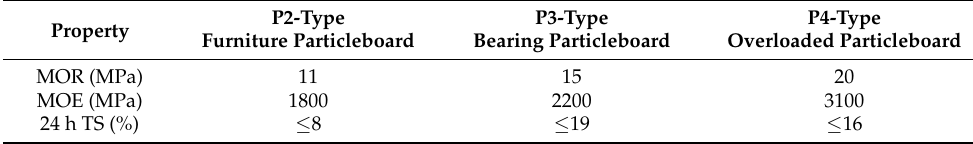
Table 5. Requirements of national standard GB/T 4897-2015 (thickness of 6–13 mm).